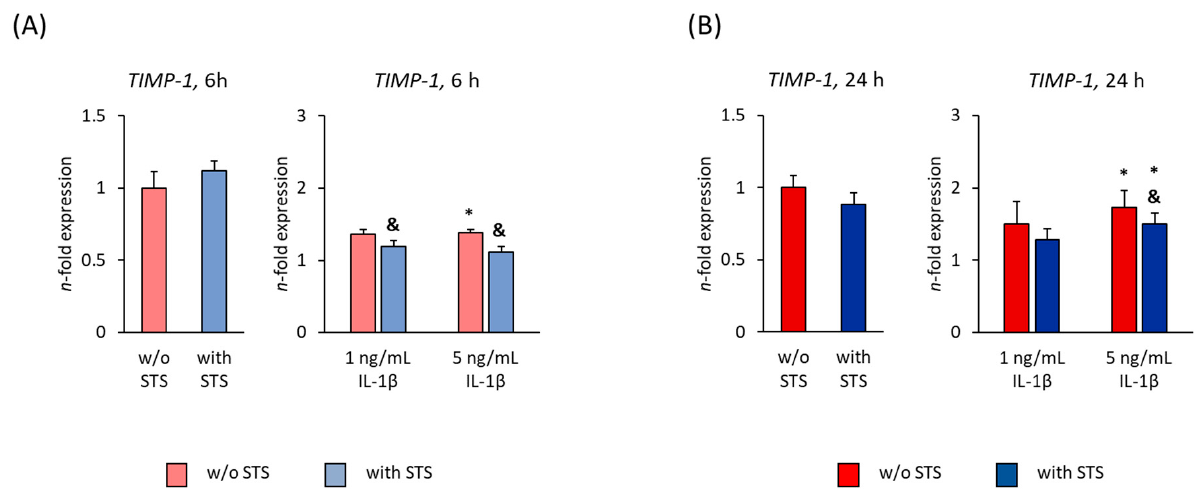
Figure 6. Effect of static orthodontic tensile forces on the IL-1 β -induced gene expression of TIMP-1 in hPDL-MSCs in the absence of FBS. STS with 6% equibiaxial elongation was applied to untreated or IL-1 β -treated hPDL-MSCs in the absence of FBS. 6 ( A ) and 24 ( B ) hours after stimulation with or without STS, qPCR was performed showing the n -fold expression levels of TIMP-1 compared to the appropriate controls ( n -fold expression = 1). GAPDH served as an endogenous control. All data are presented as mean ± S.E.M. * p -value ≤ 0.05 significantly higher compared to the appropriate control; & p -value ≤ 0.05 significantly lower compared to the appropriate Il-1 β stimulated cells without STS.